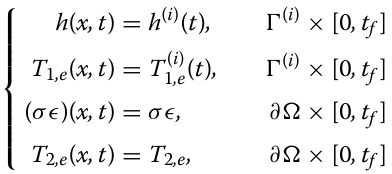
Fig. 2 Representation of the structure of interest (cid:2) , composed of 3 bodies, with a partitioning of the (cid:4) ( i ) , (cid:4) ( i ) ◦ ∩ (cid:4) ( j ) ◦ = ∅ , 1 ≤ i,j ≤ d = 39 boundary ∂(cid:2) = ∪ d i = 1 (cid:3) (cid:4) T 4 ( x, t ) − T 4 ( σ(cid:8) )( x, t ) ( x, t ) , for ( x, t ) ∈ ∂(cid:2) × [0 , t f ], where h denotes the convection 2 ,e coefficient (in J s − 1 m − 2 K − 1 ), σ the Stefan–Boltzmann constant (in J s − 1 m − 2 K − 4 ), (cid:8) is the emissivity coefficient (dimensionless), T 1 ,e and T 2 ,e are external temperature values. These coefficients are uniform on each surface (cid:4) ( i ) , 1 ≤ i ≤ d , and the radiation coefficients are also constant in